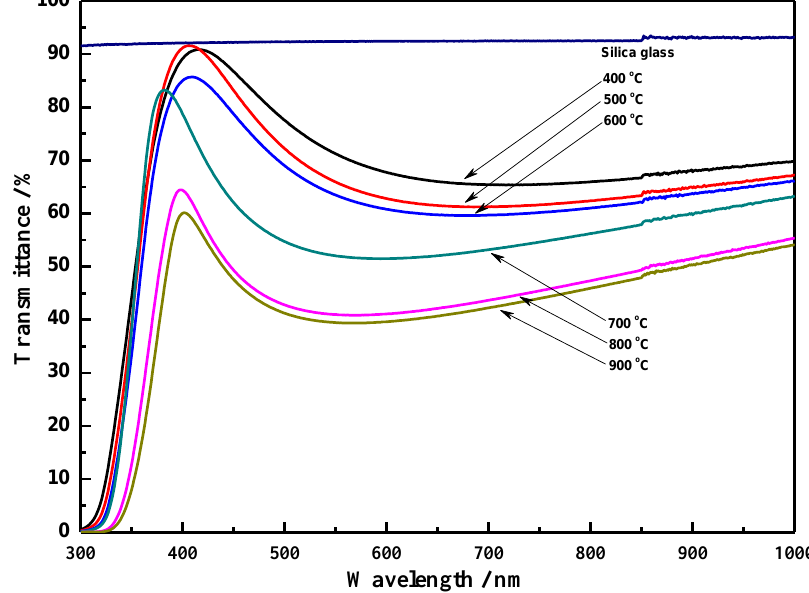
coatings annealed at different 2